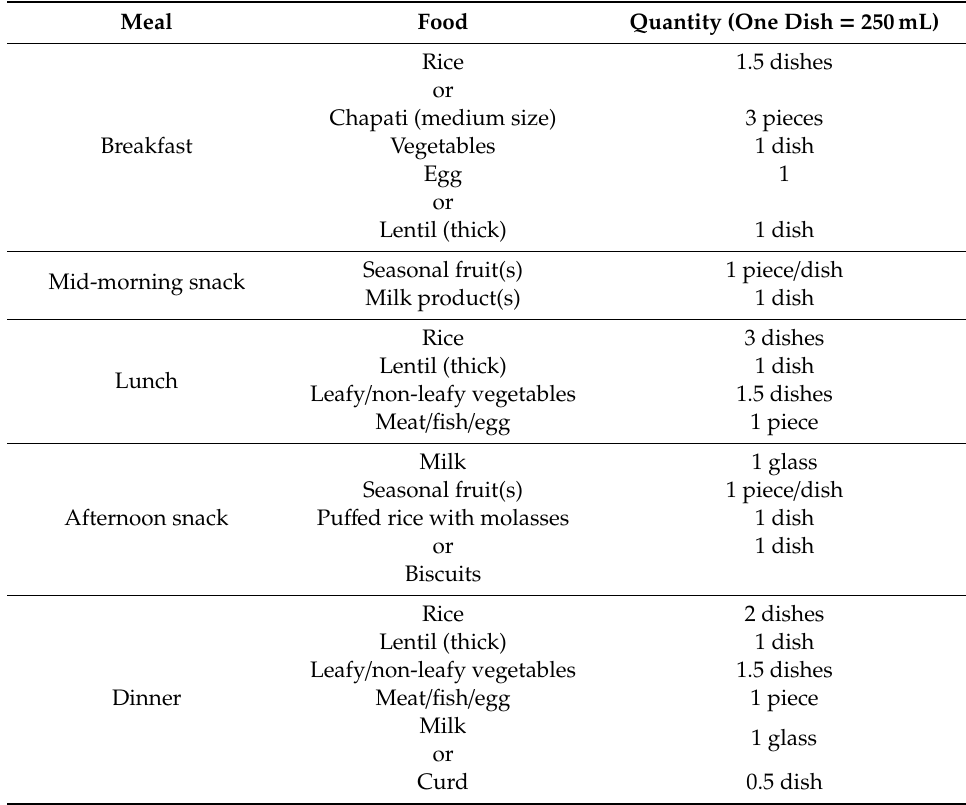
Table 1. The balanced plate menu for pregnant